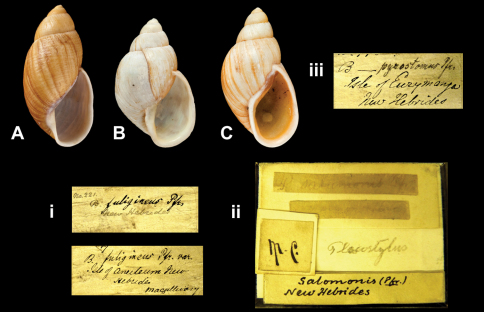
Santacharis species. A, i
Santacharis fuligineus (Pfeiffer, 1853), lectotype NHM 1975226 (H = 39.4) B–C
Santacharis salomonis (Pfeiffer, 1853) B, ii Lectotype NHM 1975234 (H = 33.6) C, iii Lectotype of Bulimus pyrostomus Pfeiffer, 1860 NHM 1975235 (H = 41.5).